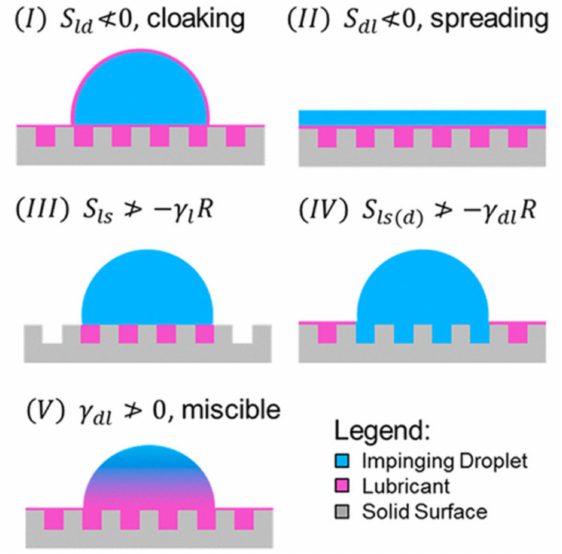
Figure 9. The possible failure modes outlined by Preston et al. for a lubricant/substrate/droplet system. The ideal droplet of impinging fluid on a slippery surface rests atop a combined lubricant- solid layer. Reproduced with permission from Ref. [221], Copyright 2017 American Chemical